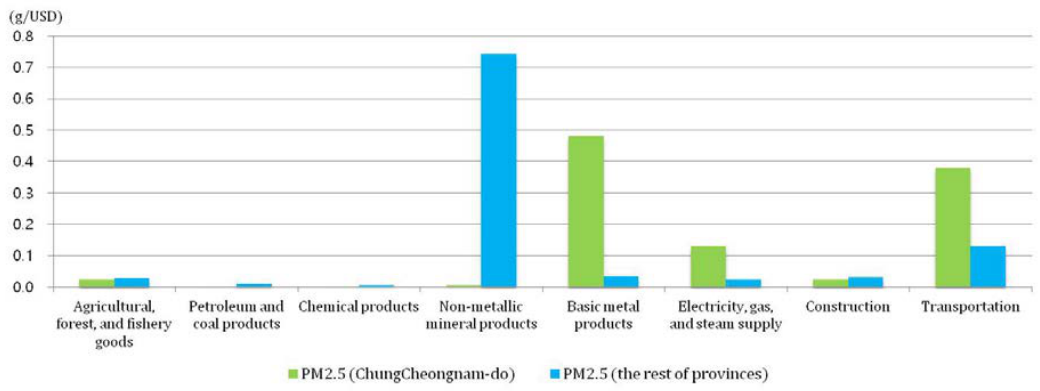
Figure 7. PM 2.5 emission per domestic production for the 8 highest emission industries in CN and